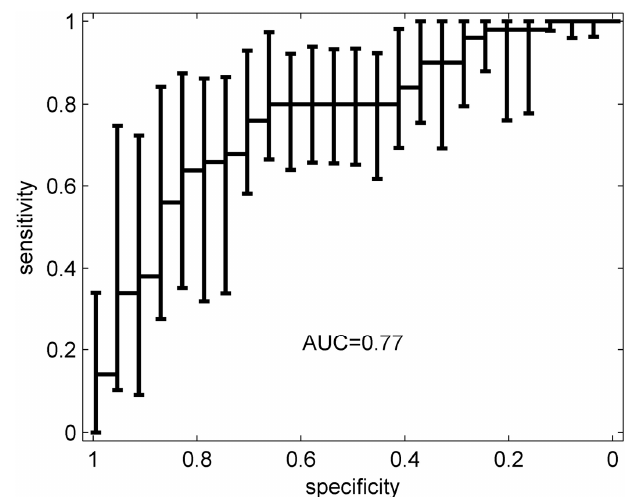
Figure 10. Total average of all data represents typical smell print of urine. Characteristics of average smell prints of BPH and PCA groups are depicted by deviation from total average. Used with permission from [33].